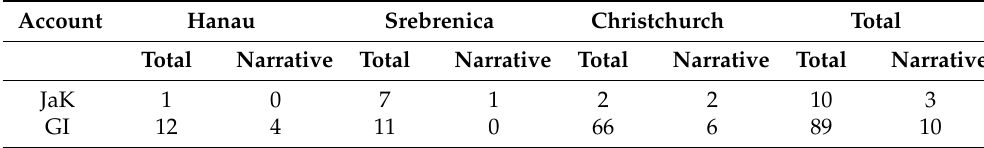
Table 2. Numbers of narratives among total numbers of